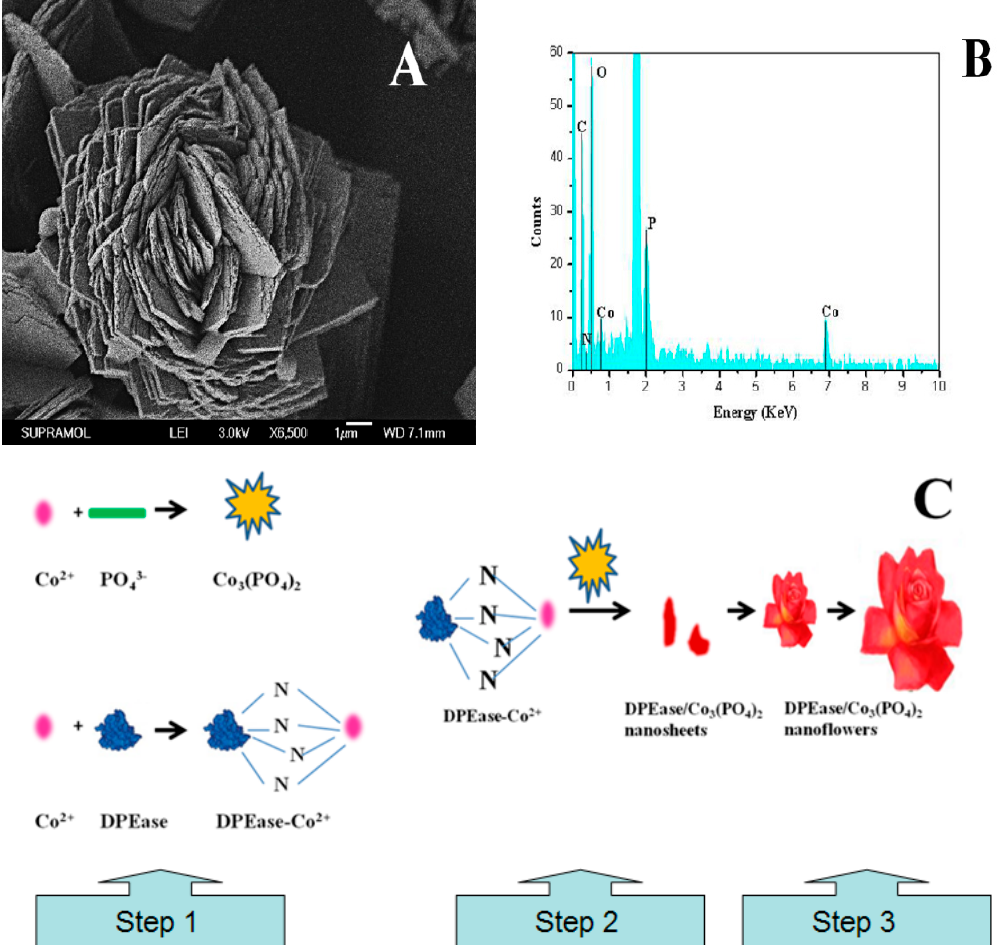
Figure 1. ( A ) Morphology of nanoflower; ( B ) EDAX analysis and ( C ) the possible mechanism of nanoflower formation.